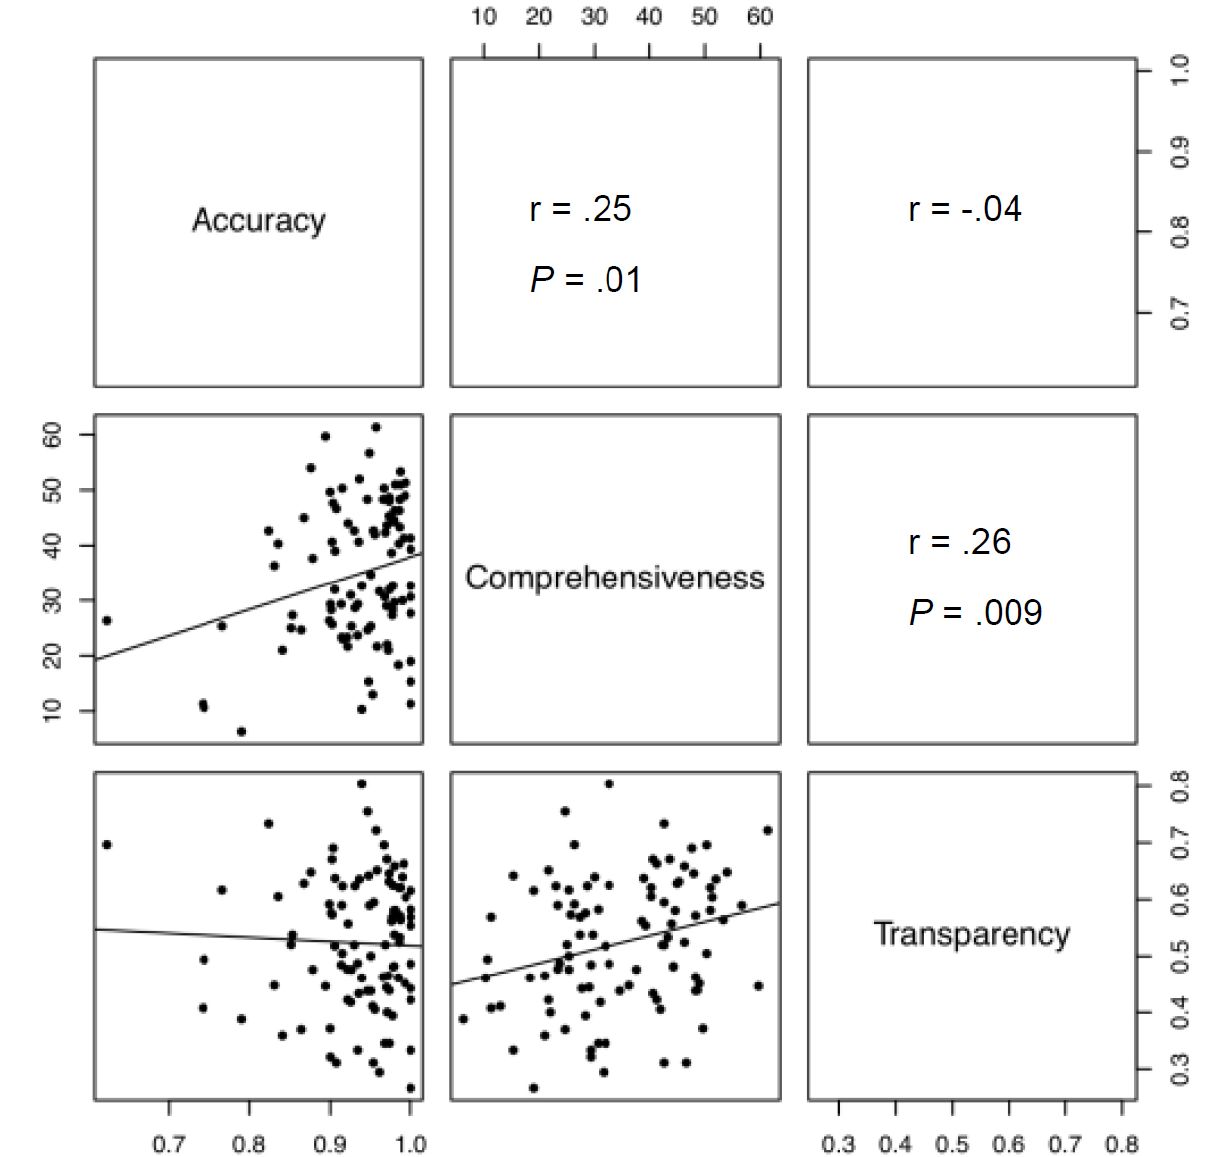
Figure 2. Matrix of scatter plots of accuracy, comprehensiveness, and transparency of the websites. The correlation coefficients ( r ) and significance values ( P ) are shown within the boxes. There was a significant positive correlation between website accuracy and comprehensiveness ( r = .25, P = .01) (dot plot shown in left middle panel) and between website comprehensiveness and transparency ( r = .26, P = .01) (dot plot shown in bottom middle panel). There was no significant correlation between accuracy and transparency ( r = -.04) (dot plot shown in left bottom panel).